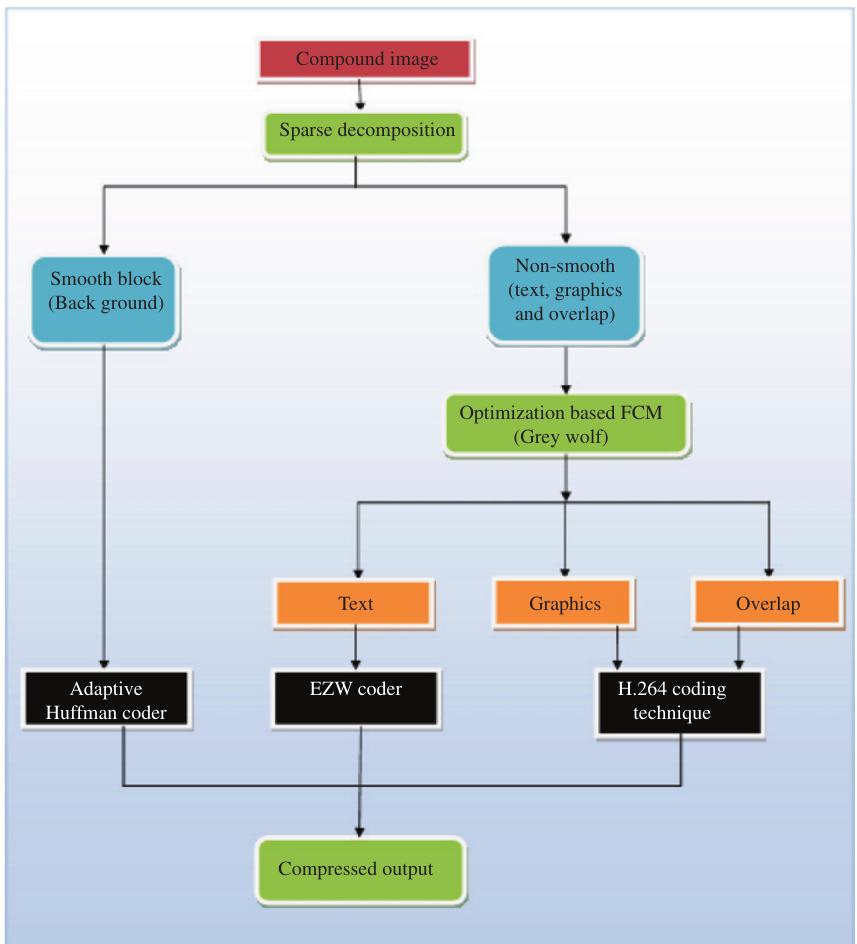
Figure 1: Flowchart of the Proposed